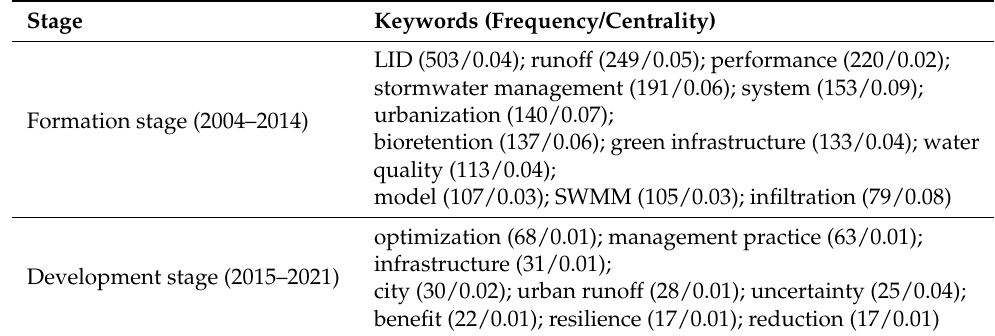
Table 3. The high-frequency keywords of publications according to the WOS database. Stage Keywords (Frequency/Centrality)